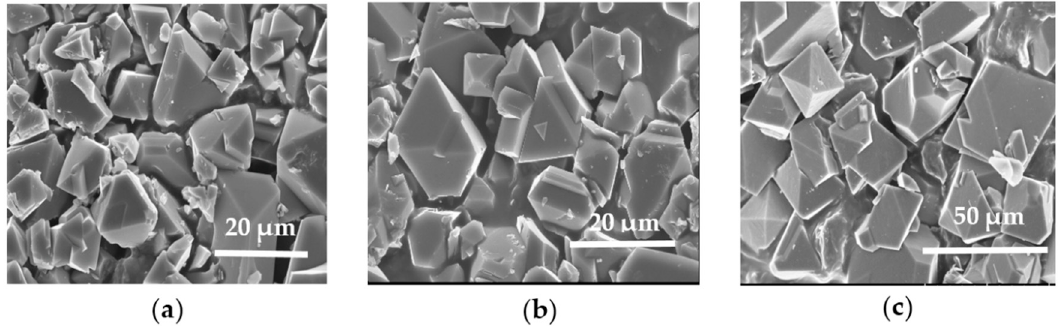
Figure 1. SEM micrographs of the HKUST-1 solv.1 ( a ), HKUST-1 solv.2 ( b ) and HKUST-1 mw ( c ) samples.